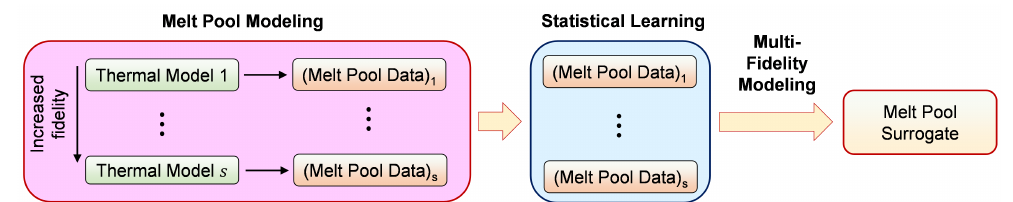
Figure 3. Presence of a hierarchy of fidelities in modeling platforms. Statistical learning integrates multi-fidelity (MF)